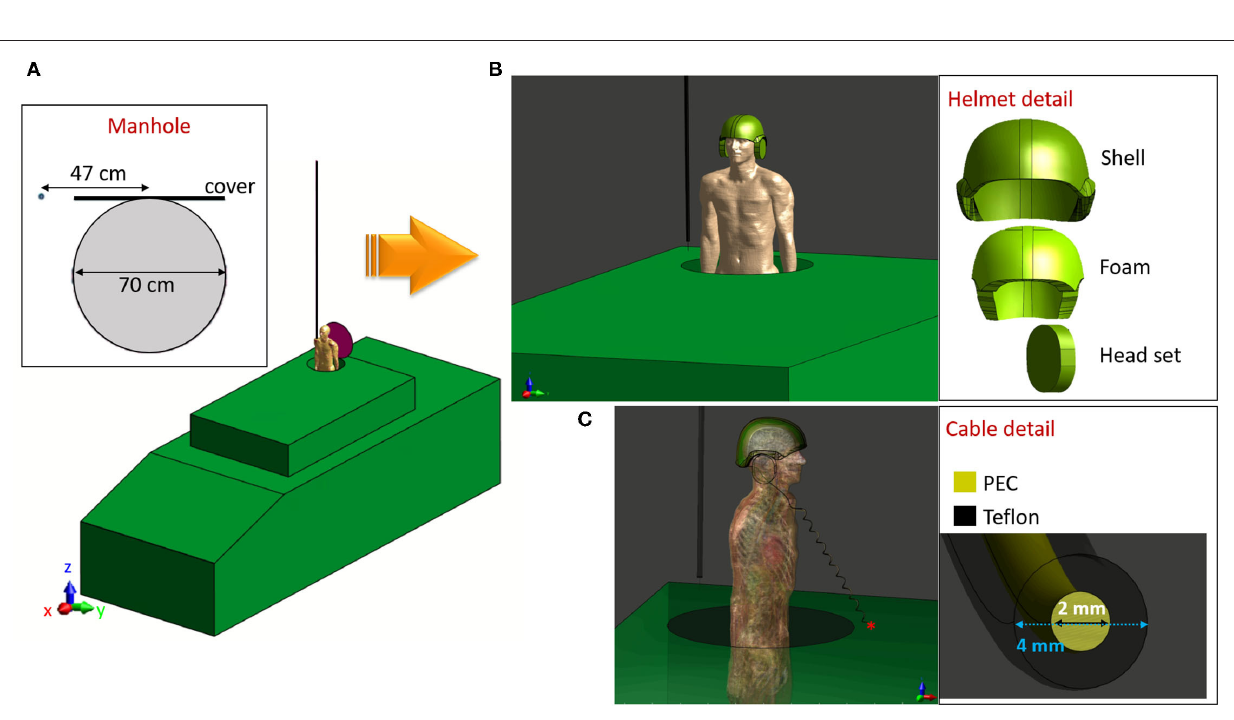
FIGURE 2 | Military personnel exposure scenario: (A) Unequipped operator standing partially outside the manhole, inset: detail of manhole position and dimensions. (B) Equipped operator wearing the protective helmet, inset: detail of the helmet composition. (C) Equipped operator wearing the protective helmet and the cabled headset, connected to the vehicle through a 10 µ F capacitor, inset: detail of the connecting